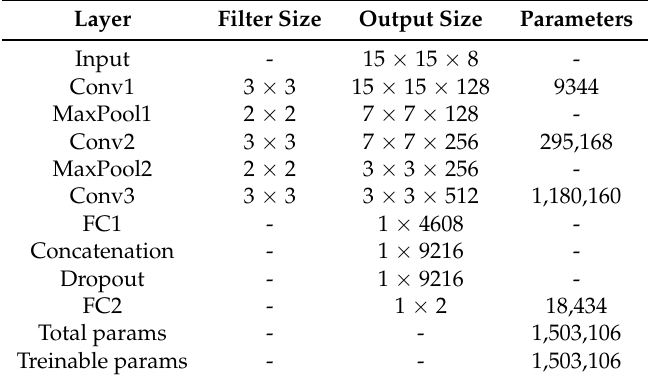
Table 4. Architecture details of the SN model.